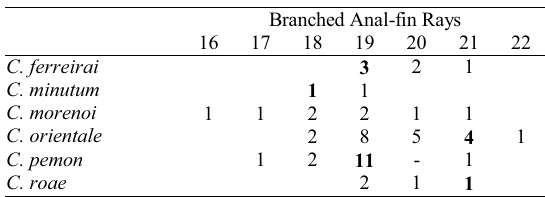
Table 8. Numbers of specimens of the species of Cetopsidium with cited number of total vertebrae. Bold indicates value for holotype when